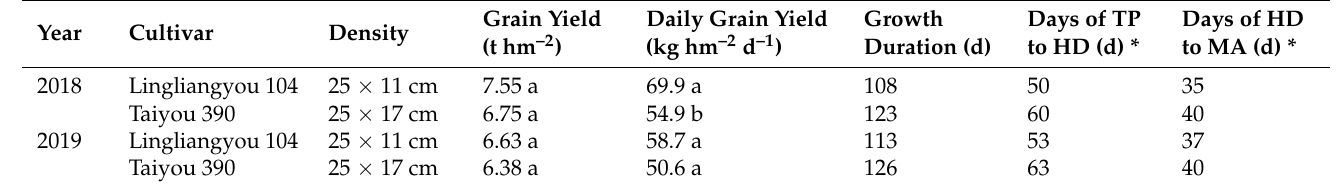
Table 1. Grain yield, daily grain yield, and growth duration of two growth duration rice cultivars under two planting densities in 2018 and 2019.